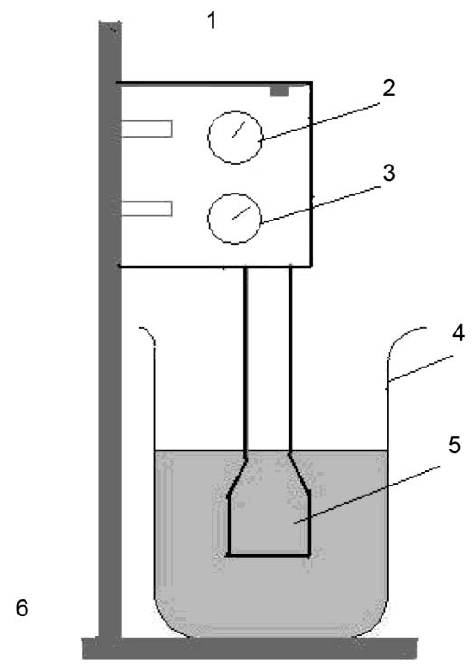
Fig. 1. Ultrasound-assisted slurry treatment reactor: 1) ultraso- nic processor, 2) power amplitude control, 3) pulse mode cont- rol, 4) reactor, 5) ultrasonic horn submerged in slurry, 6) holder